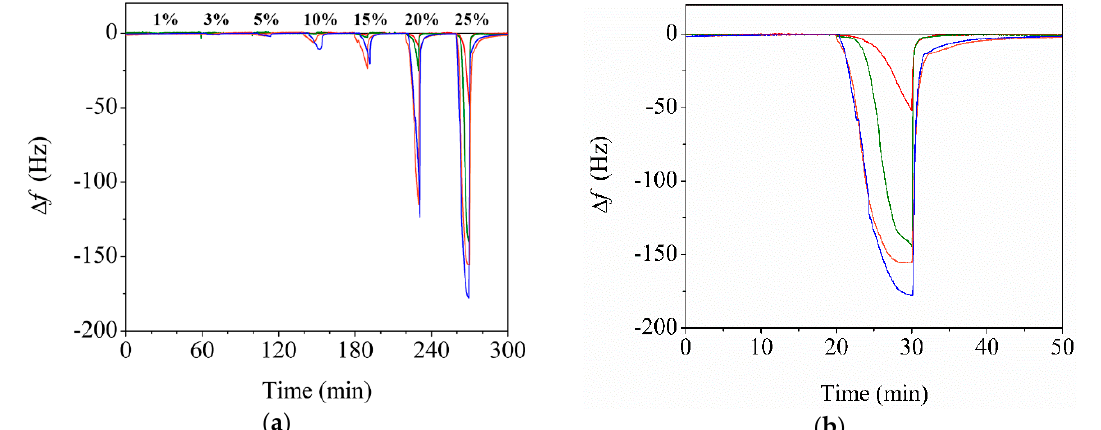
Figure 4. ( a ) Time-dependent changes in the resonance frequencies of QTF (black), P30-QTF